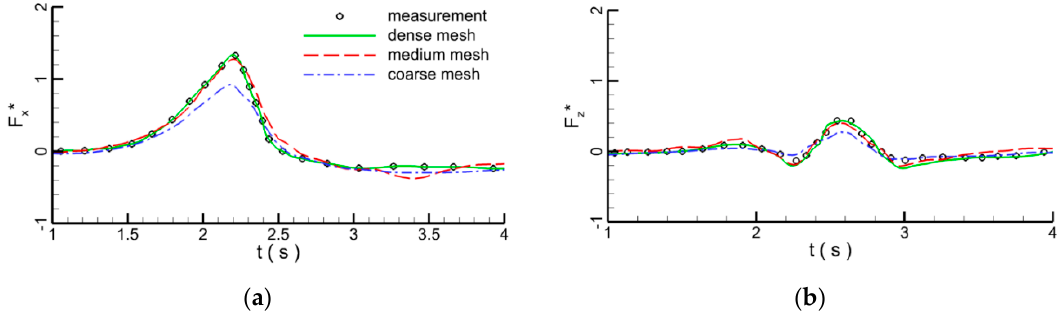
Figure 6. Force comparison between measurement and simulation in run1; ( a ) horizontal force F x *; ( b ) vertical force F z *.